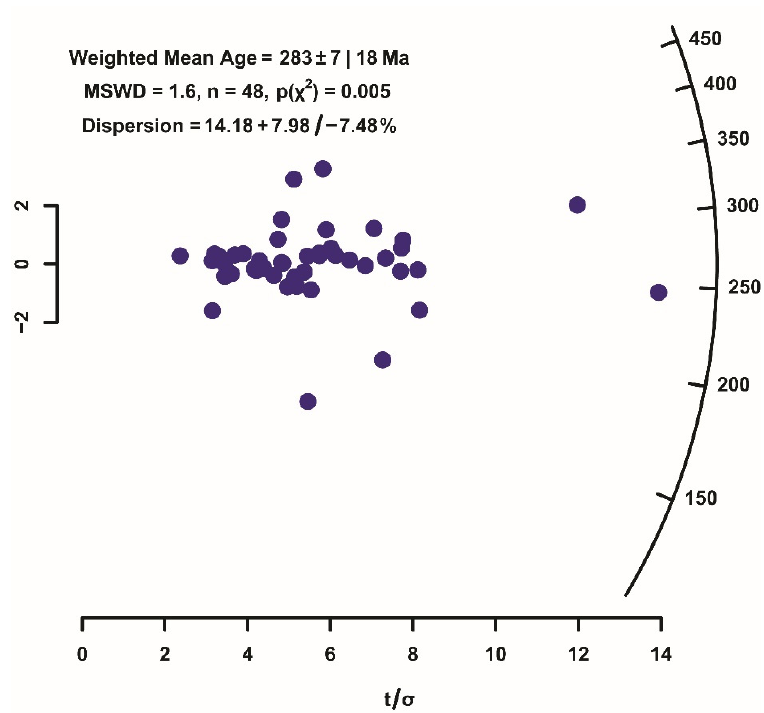
Figure 7. Radial plot diagram [89] for all dated AFT grains.